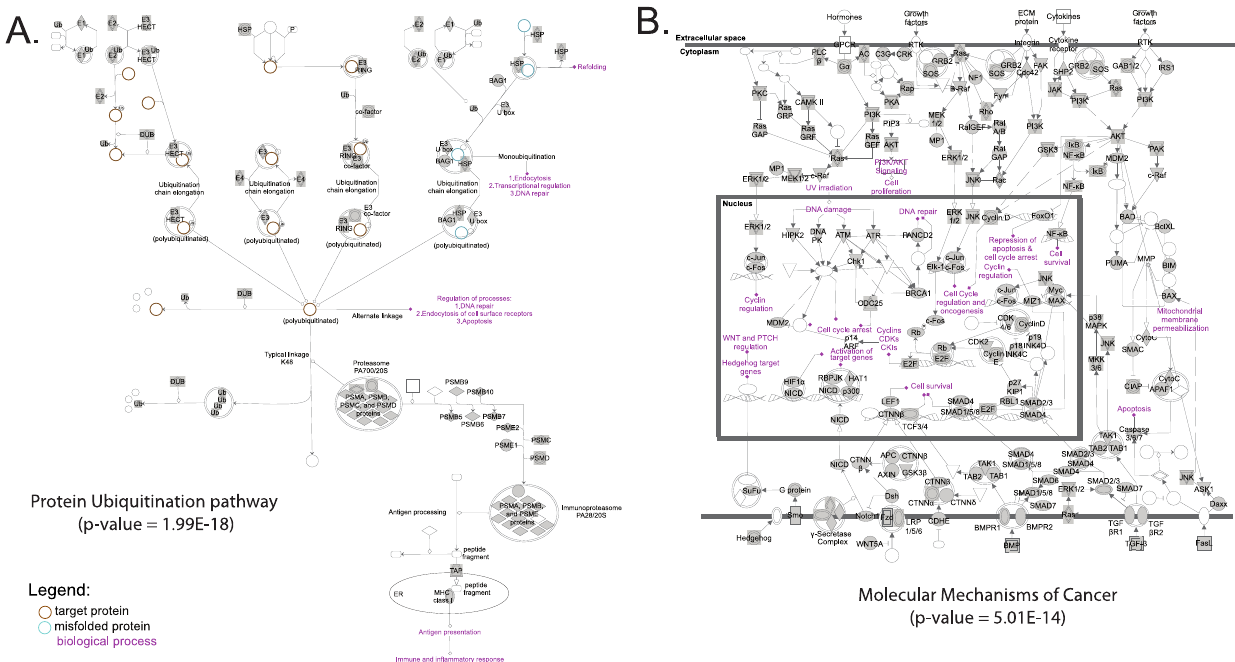
Figure 3. Schematic representation of the top two over-represented canonical pathways in our transcriptome assembly. (A) Representation of the ‘‘Protein Ubiquitination’’ canonical pathway. (B) Representation of the ‘‘Molecular Mechanisms of Cancer’’ canonical pathway. Both pathways have been generated based on mouse annotations. Transcripts involved in these pathways are indicated by different node shapes and associations are indicated by different edge shapes. Legends for the different nodes and edges are given in Figure S1 . For both pathways, transcripts present in our library are indicated in gray. Associated p-values showing the statistical over-representation significance of the canonical pathways are also indicated.